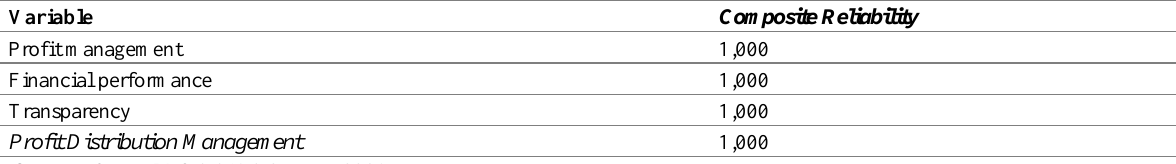
Table 4: Measurement of Composite Reliability